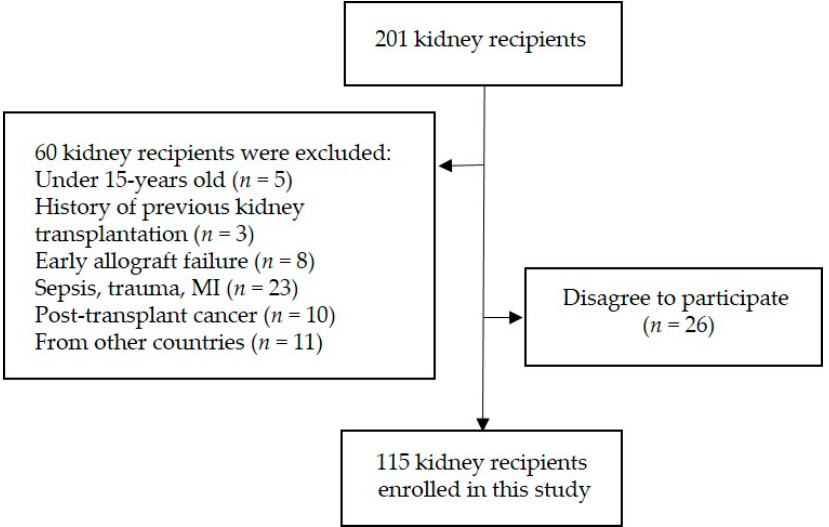
Figure 1. A flow-chart of patients selection. Table 2. Demographic and baseline clinical data.